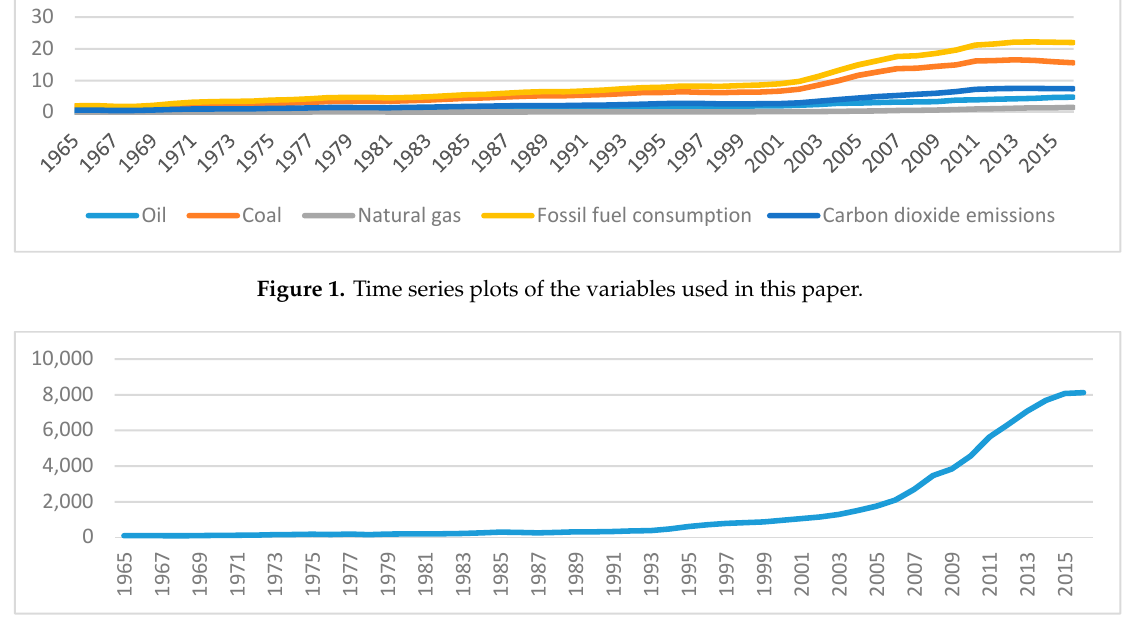
Figure 2. Time series plot of GDP per capita (current US$).